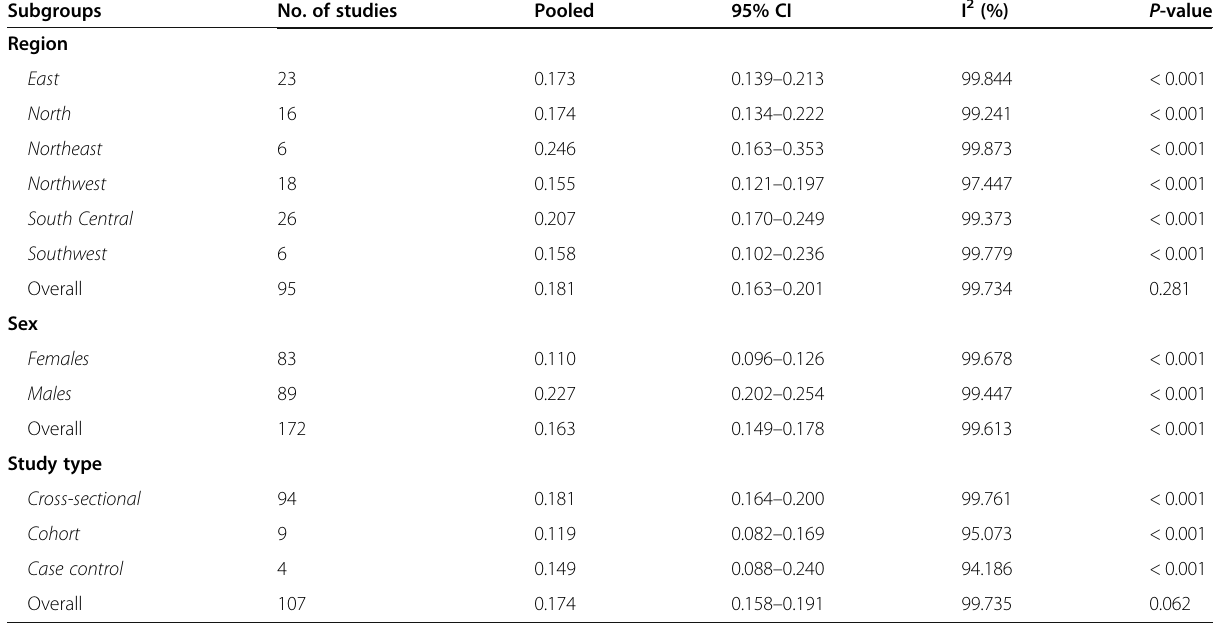
Table 2 Prevalence of hyperuricemia by subgroups in mainland China